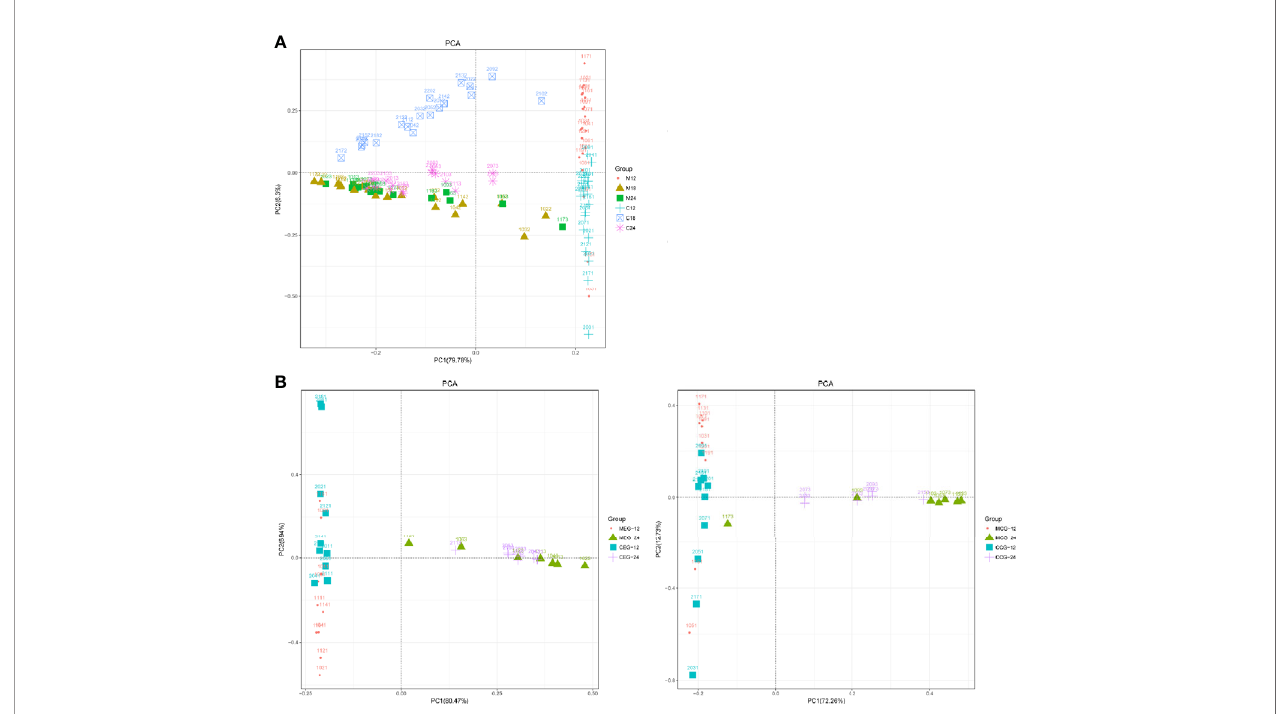
FIGURE 3 | PCA based on the UniFrac distances at the OTU level at 97% identity for (A) mother (M) and child (C) at 12, 18, and 24 months of age; (B) M or C in the exposure group (MEG or CEG) and the control group (MCG or CCG) at 12 and 24 months of age.